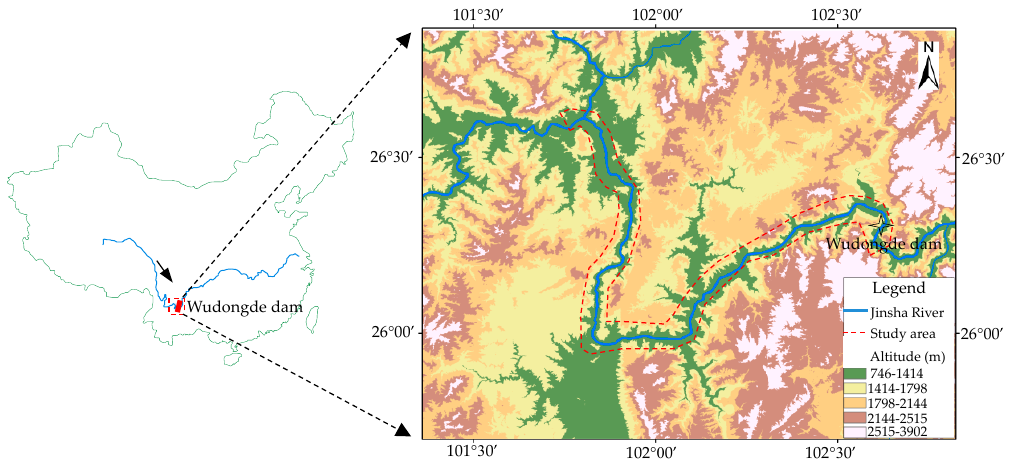
Figure 1. Location map of the study area [30].